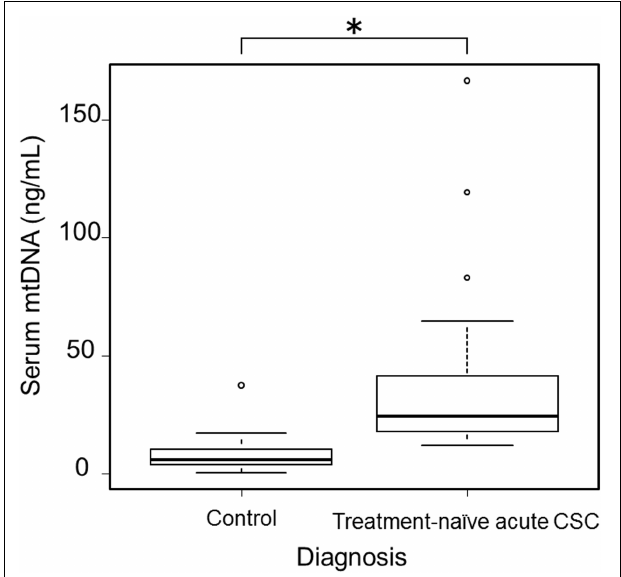
FIGURE 2 | Boxplots showing serum mtDNA levels in healthy control participants ( n = 50) and treatment-naïve acute CSC patients ( n = 33). A significant increase in serum mtDNA levels was observed in treatment-naïve acute CSC patients ( ∗ p < 0.001). mtDNA, mitochondrial DNA; CSC, central serous